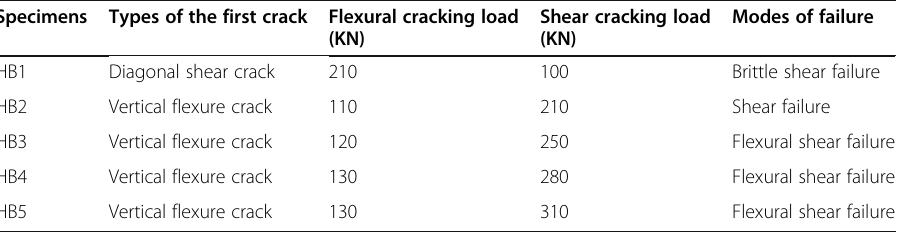
Table 9 Cracking properties and modes of failure Specimens Types of the first crack Flexural cracking load (KN)